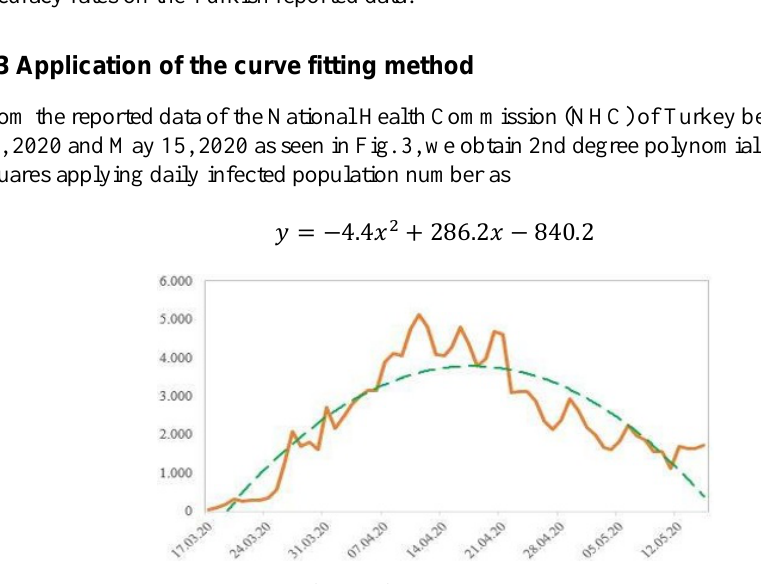
Fig. 3. 2nd degree polynomial curve fitting of estimating peak